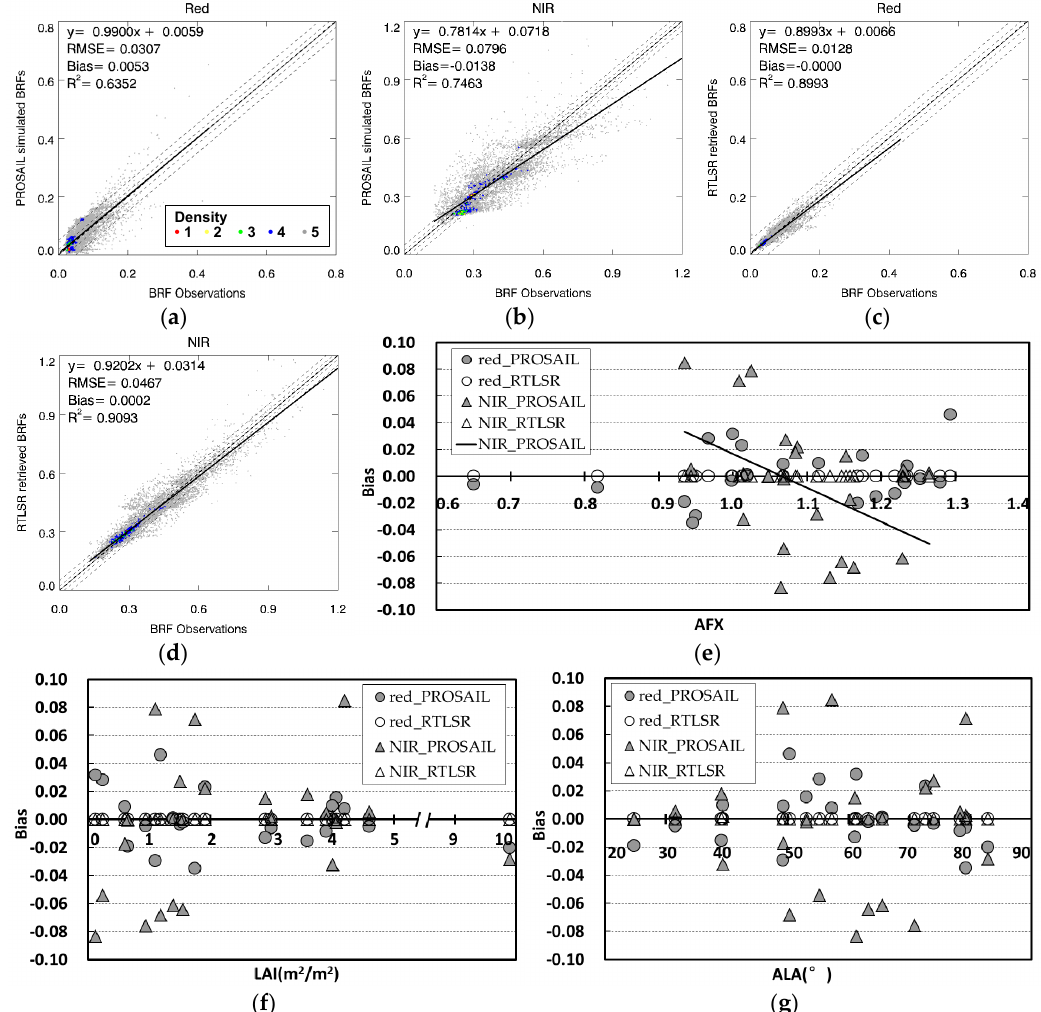
Figure 7. Comparison of the directional reflectances between the PROSAIL simulation and RTLSR inversion in the red and NIR bands for 21 sets of observations, where the two gray dashed lines show the 0.02 and 0.05 tolerances: ( a , b ) comparison of the directional reflectances between the PROSAIL simulation and observations at five equal density levels from 1 (maximum) to 5 (minimum). ( c , d ) Comparison for RTLSR retrievals and observations. ( e – g ) Relationships between bias and three parameters, which are AFX, LAI and ALA,